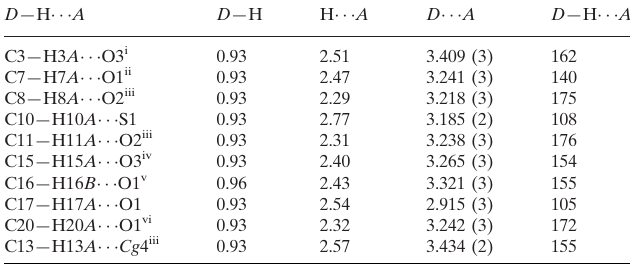
Hydrogen-bond geometry (A˚ , (cid:4) ). Cg 4 is the centroid of the C17–C22 benzene